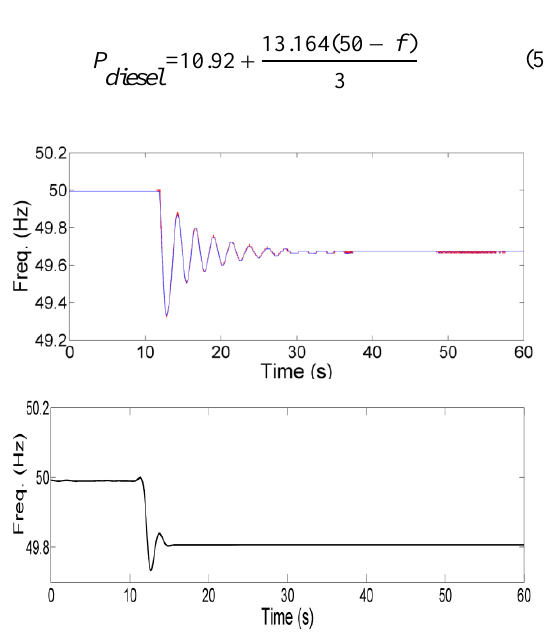
Figure 17. Frequency response (load change) without & with storage.